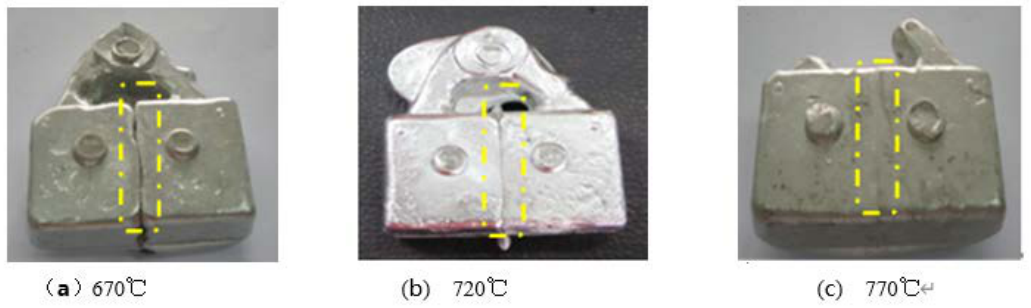
Figure 4. Casting bonding surfaces with di ff erent casting temperatures ( a ) 770 ◦ C, ( b ) 670 ◦ C, and ( c ) 720 ◦ C. Table 4. Fracture splitting surface quality with di ff erent casting temperatures.